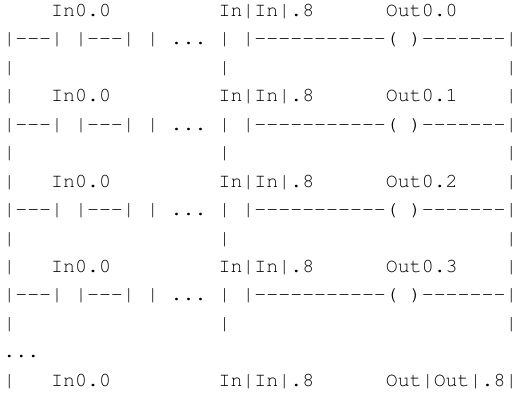
Figure 5. Ladder logic for experiment